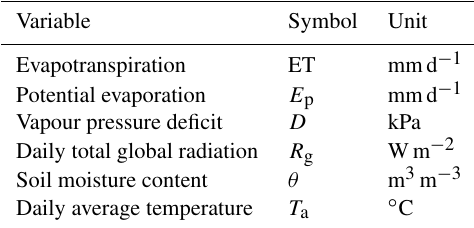
Table 1. Meteorological characteristics and their